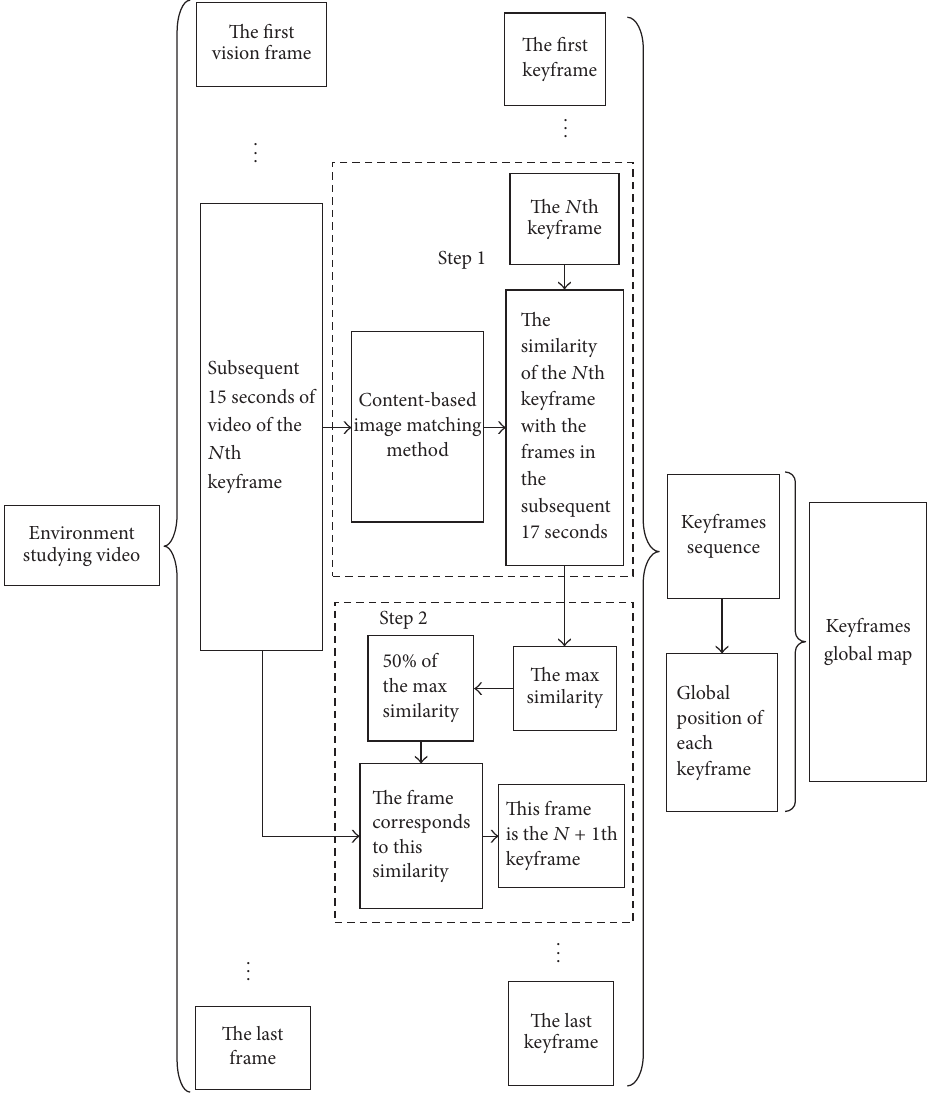
Figure 10: The image processing of keyframes global